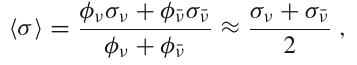
Fig. 18 FASER ν ’s estimated ν -nucleon CC cross section sensitivity for ν e (left), ν μ (center), and ν τ (right) at Run 3 of the 14 TeV LHC with an integrated luminosity of 150 fb − 1 collected from 2021-23. Existing constraints [42] are shown in gray for σ ν and σ ¯ ν at accelerator exper- iments and for their weighted average at IceCube. The black dashed curve is the theoretical prediction for the average DIS cross section per tungsten-weighted nucleon, as introduced in (5). The solid error bars